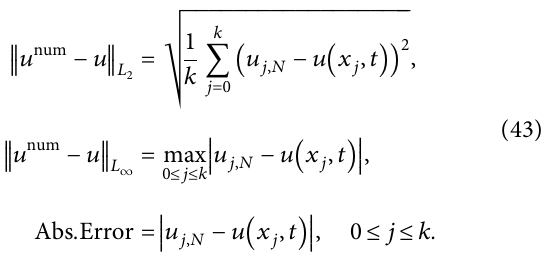
k � 10. It indicates that the results obtained with the presented algorithm are in good match with the exact solutions and absolute errors are better than those given in [31]. We have tabulated the numerical solutions for Example 1 at T � 1 with h � 0 . 01, ] � 0 . 1, and α � 0 . 9 in Table 3. Te shape parameters are c � 3 . 933, c � 5 . 138, and c � 5 . 289 for k � 30, k �